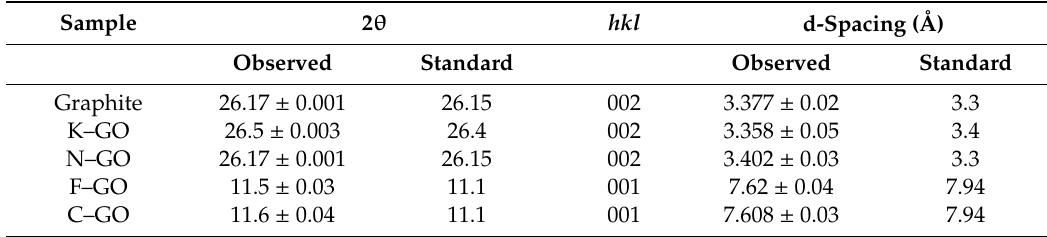
Table 2. Average d-spacing of GO